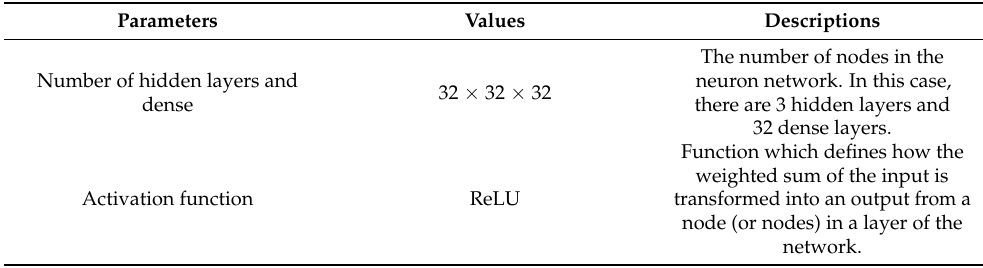
Table 1. List of hyperparameters and their